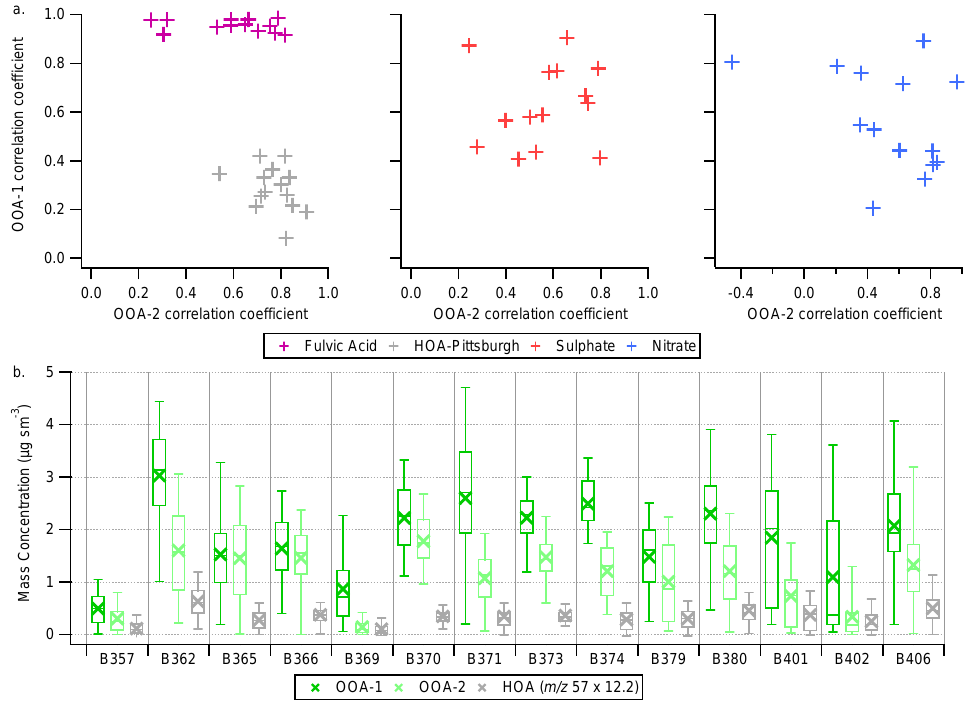
Fig. 4. (a) Summary of correlations for OOA-1 and OOA-2 with both reference mass spectra and external time series. Uncentered correlation coefficients are used for the mass spectra, while Pearson’s R are used for the external time series. The fulvic acid mass spectrum is from Alfarra et al. (2004) and the HOA-Pittsburgh refers to to the deconvolved HOA solution from Zhang et al. (2005a). (b) Boxplot summary statistics of OOA-1, OOA-2 and estimated HOA mass concentrations for each flight considered in the analysis. Crosses represent the mean value, while horizontal lines represent the 25th, 50th and 75th percentiles. The whiskers represent the 5th and 95th